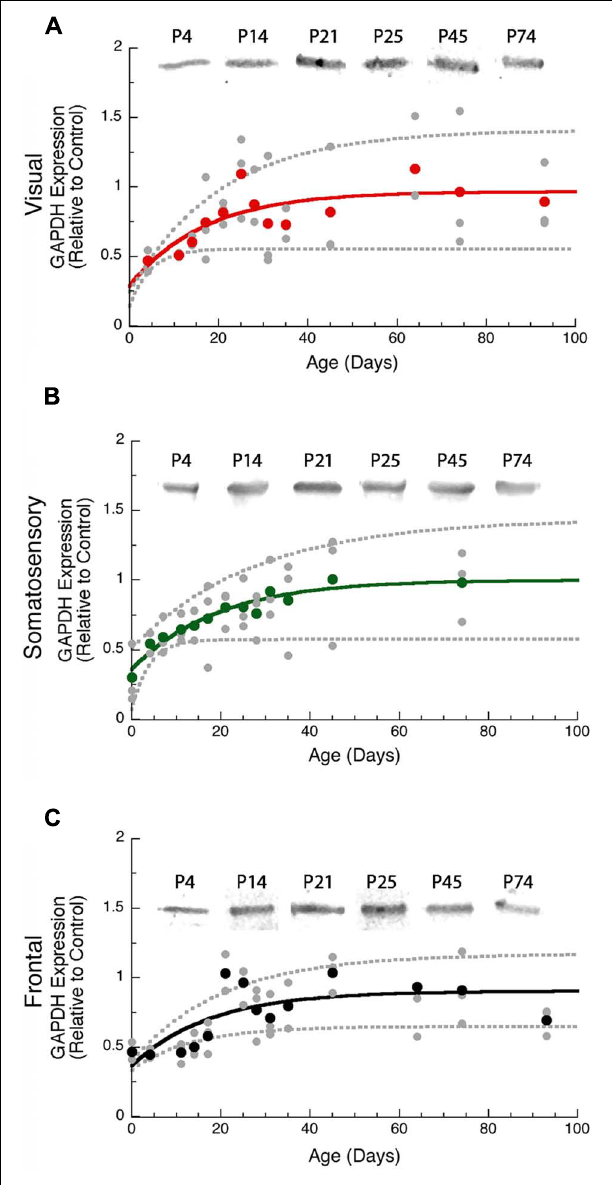
FIGURE 1 | Developmental changes in GAPDH in rat visual (red,A), somatosensory (green, B), and frontal (black, C) cortex. Gray dots are results from all runs, and color dots are the average for each animal. Example bands are shown above the graphs. Exponential decay functions were fit (solid lines), and 95% confidence intervals (dotted lines) were added, adult levels are defined as 3 τ . GAPDH reached adult levels in visual (A) at P50 (3 τ = P49.9 ± 30.4; curve-fit R = 0.50; p < 0.001), somato- sensory (B) at P57 (3 τ = P57.1 ± 26.9; curve-fit R = 0.69; p < 0.0001), and frontal (C) at P53 (3 τ = P52.6 ± 24.3; curve-fit R = 0.69; p <